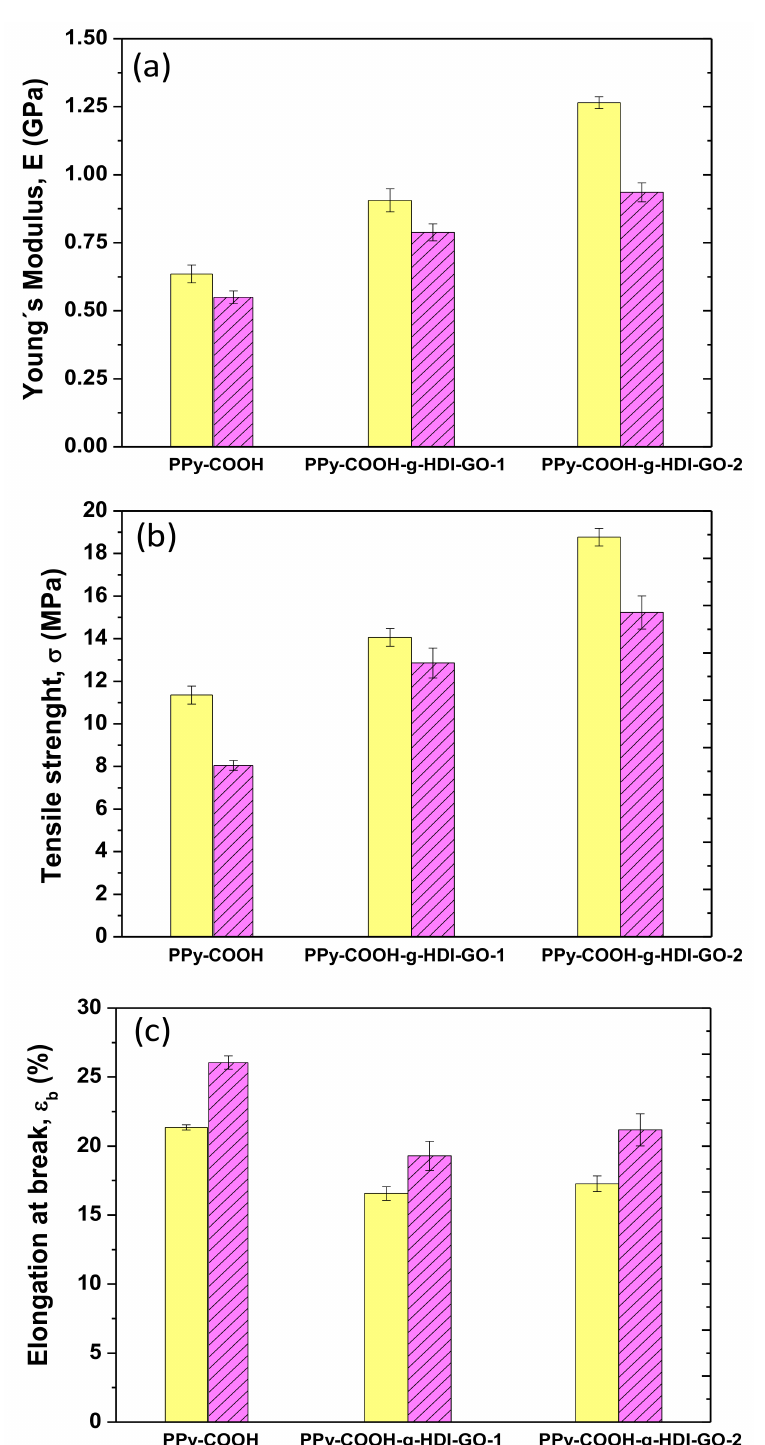
Figure 7. Tensile properties of PPy-COOH and the grafted samples at 25 ◦ C (solid bars) and 100 ◦ C (dashed bars): Young´s modulus ( a ), tensile strength ( b ) and elongation at break ( c